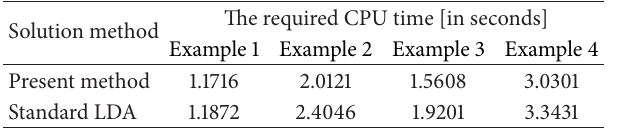
Table 5: The CPU time analysis of the present method and the standard LDA for obtaining the first three components of Examples